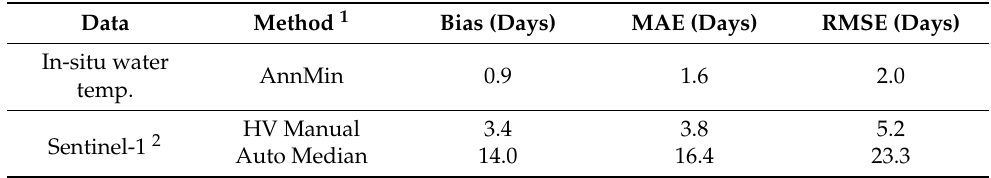
Table 4. Agreement between manual FUE dates from water temperature dynamics (the “WTemp Manual” method) and other FUE estimation methods ( n =